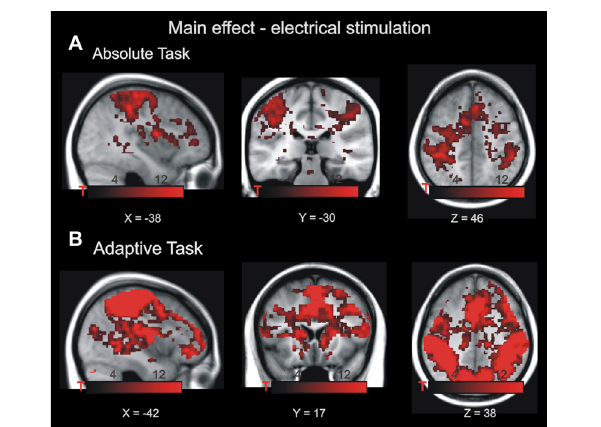
FIGURE 2 | Main effect of electrical stimulation in the absolute task (A) and adaptive task (B) . The highlighted voxels exhibited increased BOLD activity during noxious stimulation p < 0.001, family-wise error (FWE)-corrected at cluster level. Maps of activations are superimposed on a T1 group template. Note that both tasks require different cognitive demands; therefore, both main effects are not formally